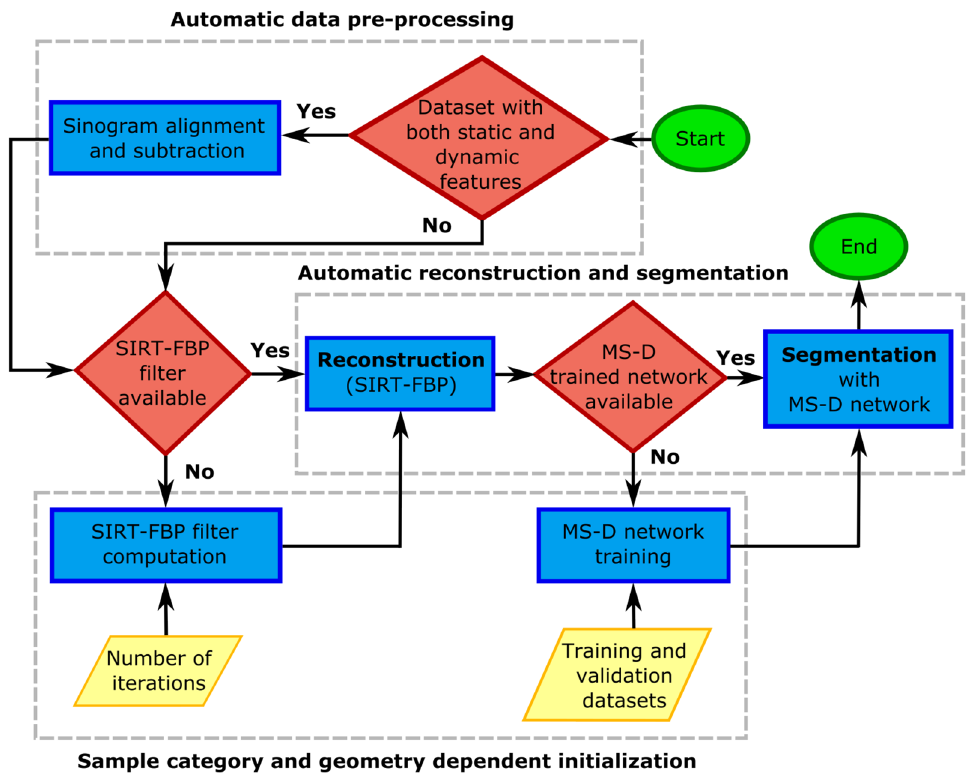
Figure 2. Algorithm protocol flowchart. The algorithm protocol starts with an automatic data pre-processing step to extract the dynamic components. For each experiment geometry a SIRT-FBP filter needs to be computed, and for each sample category (e.g. fuel cell, porous media, foams) a MS-D network trained. If these 2 elements are available, reconstruction and feature extraction can be performed fully